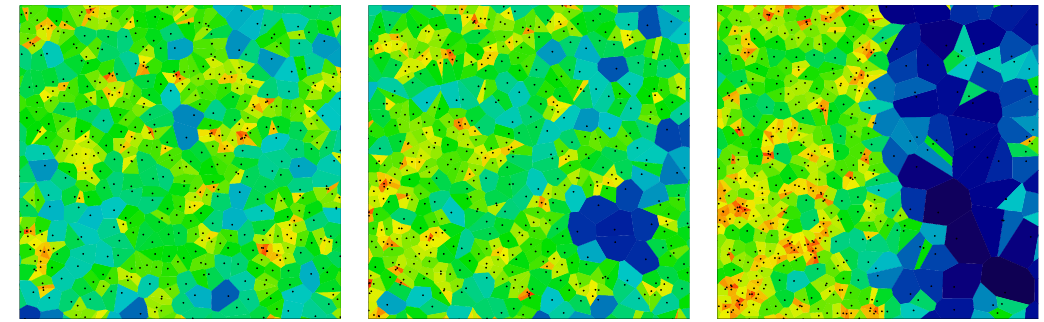
Figure 5 . Pictorial illustration of the identification (3.1) for the case of the three point datasets shown in figure 1. The Voronoi cells are color-coded by their inverse areas with warm (cold) colors indicating large (small) values of f